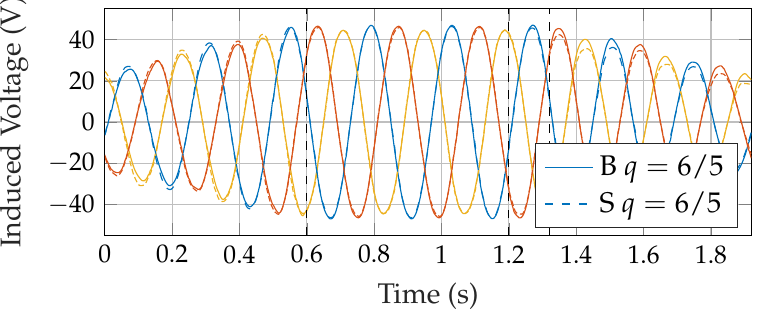
Figure 14. Phase voltages for q = 6 for both topologies. The stroke length allows for 50 % active 5 stator area. Full stator overlap for buried (B) and surface (S) topologies is from t = 0.6 s to t = 1.32 s and t = 1.2 s, respectively, indicated by the dashed vertical lines. The different phases are indicated by different colors.